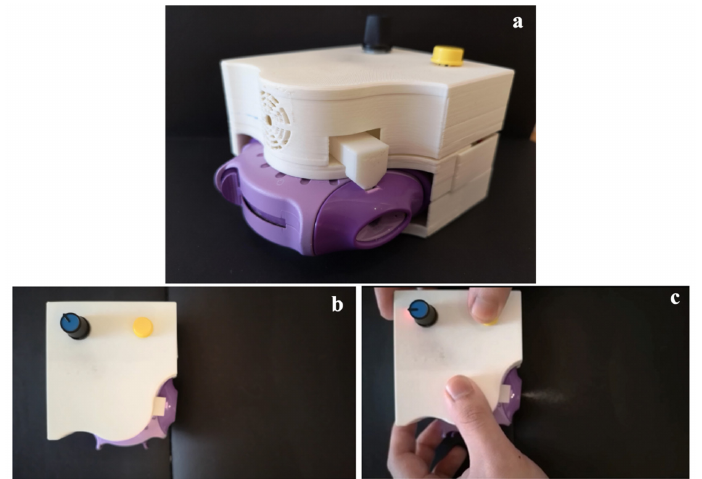
Figure 4. ( a ) Assembly of the 3D printed add-on device and Accuhaler and ( b , c ) expulsion of drug from the Accuhaler upon actuation of the yellow button on the add-on